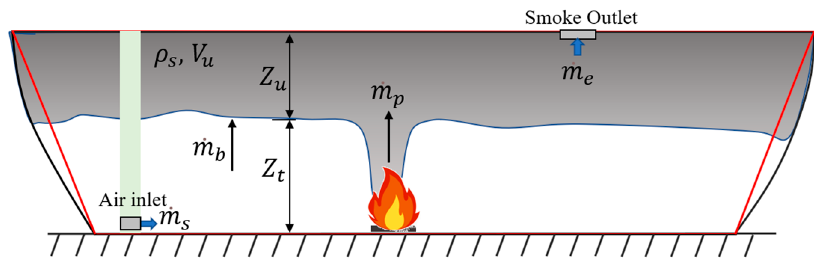
Figure 12. Schematic diagram of the smoke stratification in the engine cabin.